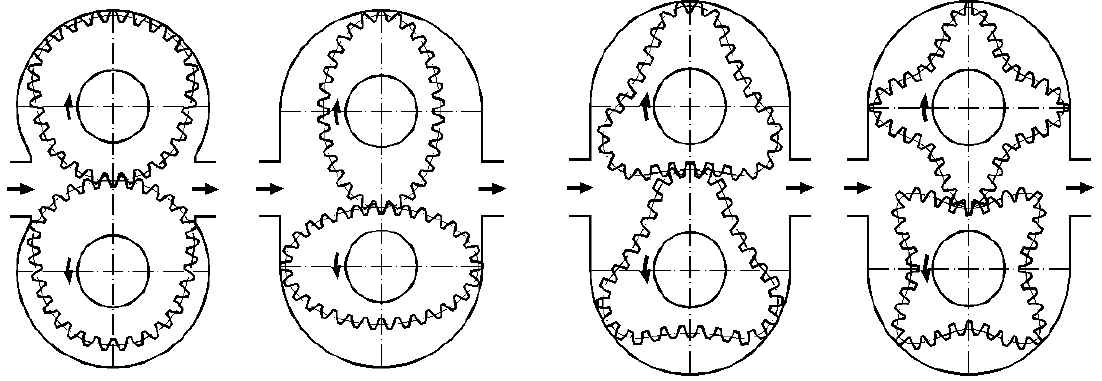
Figure 1. Examples of flow pumps using non-circular gears.